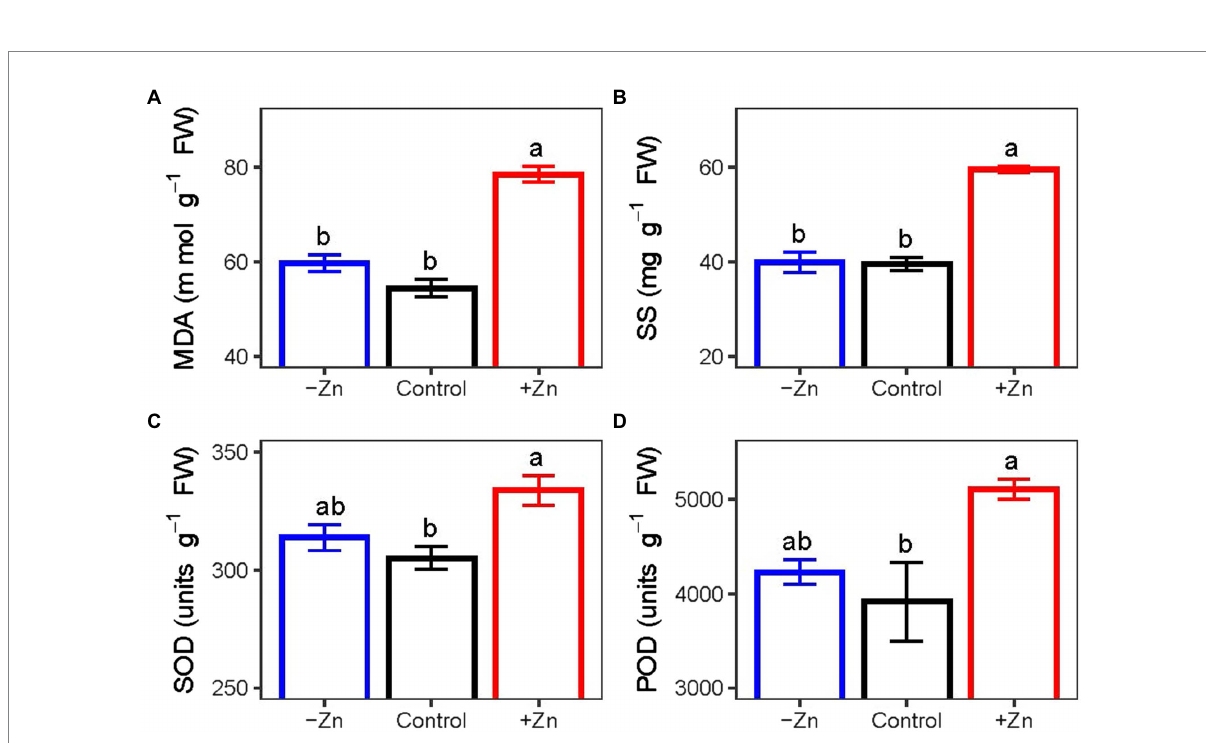
FIGURE 3 The concentrations of ( A ) MDA and ( B ) SS and activities of ( C ) SOD and ( D ) POD of C. arborescens subjected to Zn-deficient (0 mM L − 1 ), control (0.015 mM L − 1 ), and Zn-excess (0.15 mM L − 1 ) conditions. Different lowercase letters indicate significant differences among treatments ( p <